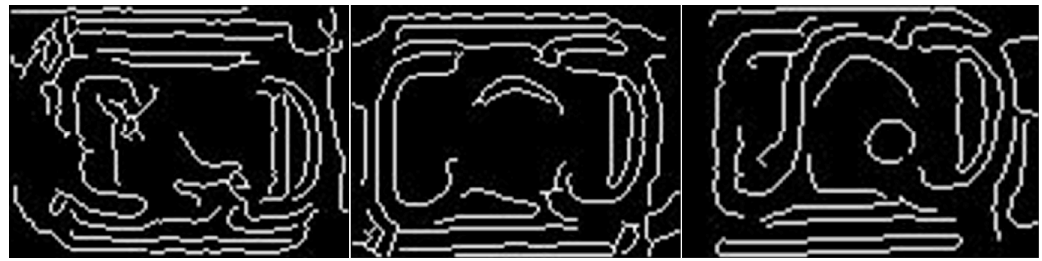
Figure 4. Canny edge detection for fastener